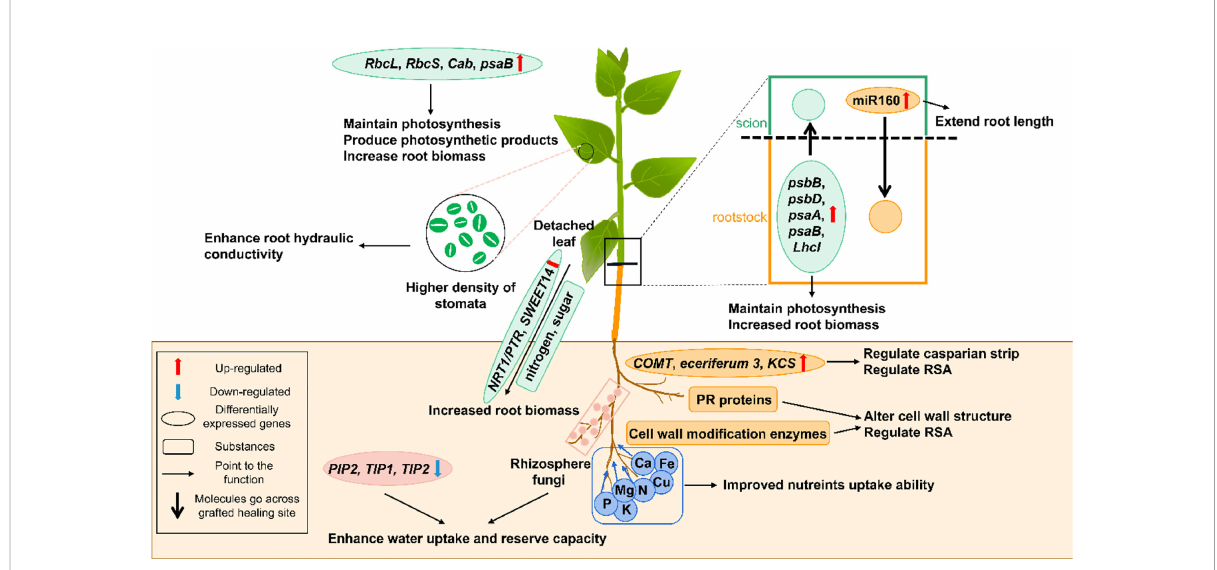
FIGURE 1 A schematic model shows the physiological and molecular mechanisms that enhancing drought resistance by root and shoot regulation in grafted plants. The green part represents for the scion, and the brown part represents for the rootstock. The black box shows the fi gure notes. Cab , chlorophyll a/b binding protein ; COMT , caffeic acid 3-O-methyltransferase ; KCS , 3-ketoacyl-CoA synthase ; LhcI , photosystem I light- harvesting chlorophyll a/b-binding protein ; NRT1/PTR , nitrate transporter 1/peptide transporter ; PIP , plasma membrane intrinsic proteins ; psaA